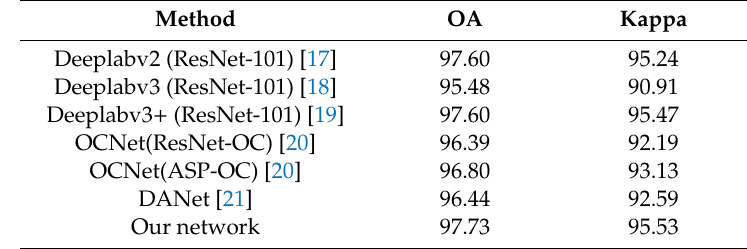
Table 7. Comparison of classification performance of di ff erent deep learning methods.